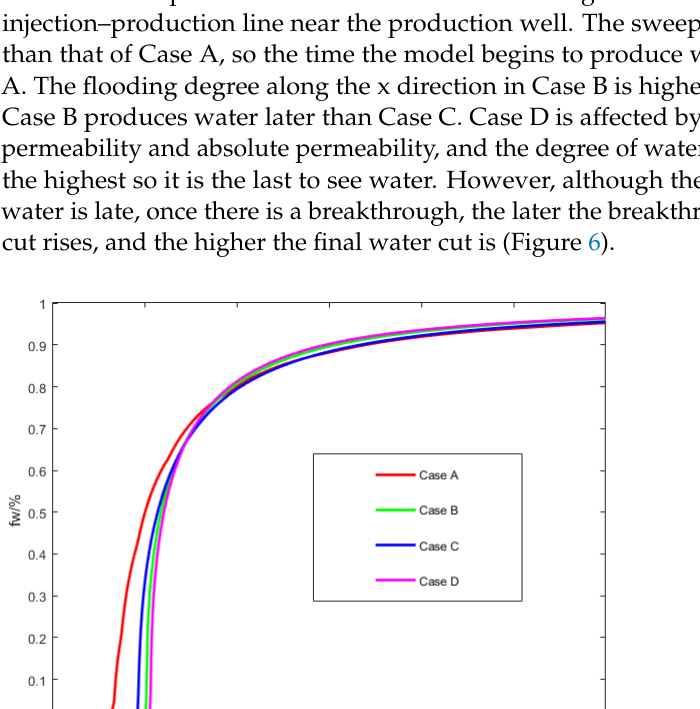
Figure 5. The remaining oil saturation distribution of the four cases at the 50th time step.